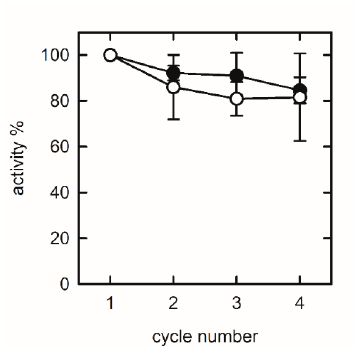
Figure 7. Effect of NaCl on biosensor reuse. Before each cycle, the puuE-doped gel was rinsed in 100 mM potassium phosphate buffer, pH 7.0, in the presence (open circles) or in the absence (closed circles) of 150 mM NaCl. Data were collected from single-wavelength CD kinetics at 210 nm in the presence of 0.2 mM racemic allantoin in 20 mM potassium phosphate, pH 7.4, at 37 °C. Activity is expressed as percentage with respect to the first cycle of use. Data are represented as mean ± s.d. of three replicates and lines are for eye-guidance only.